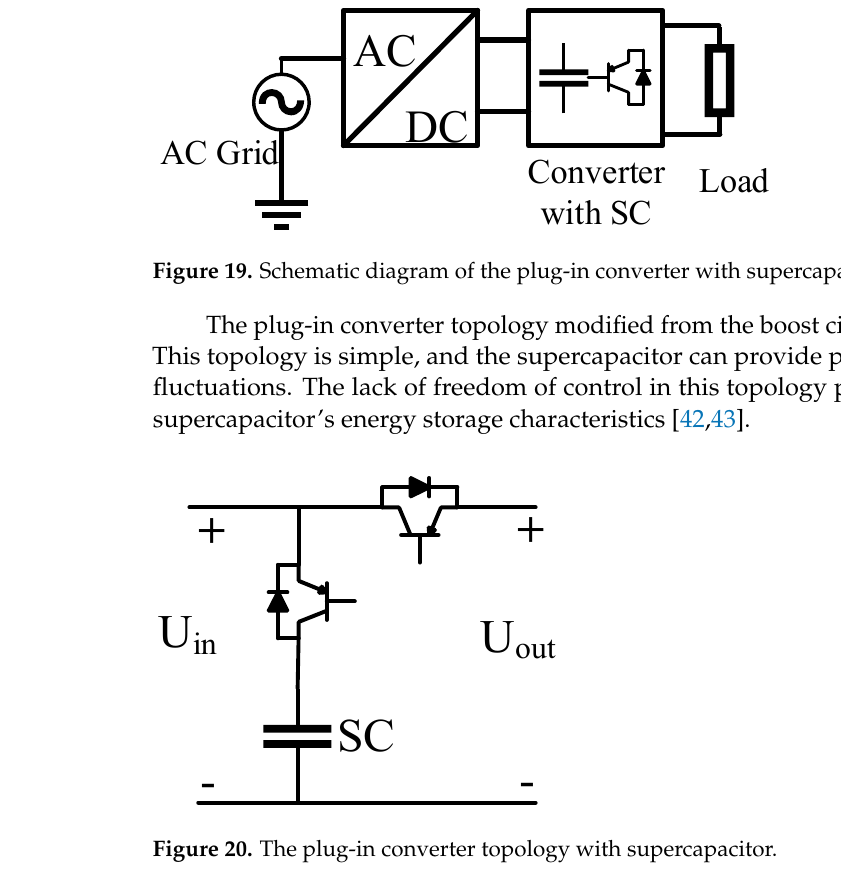
Figure 20. The plug-in converter topology with supercapacitor.